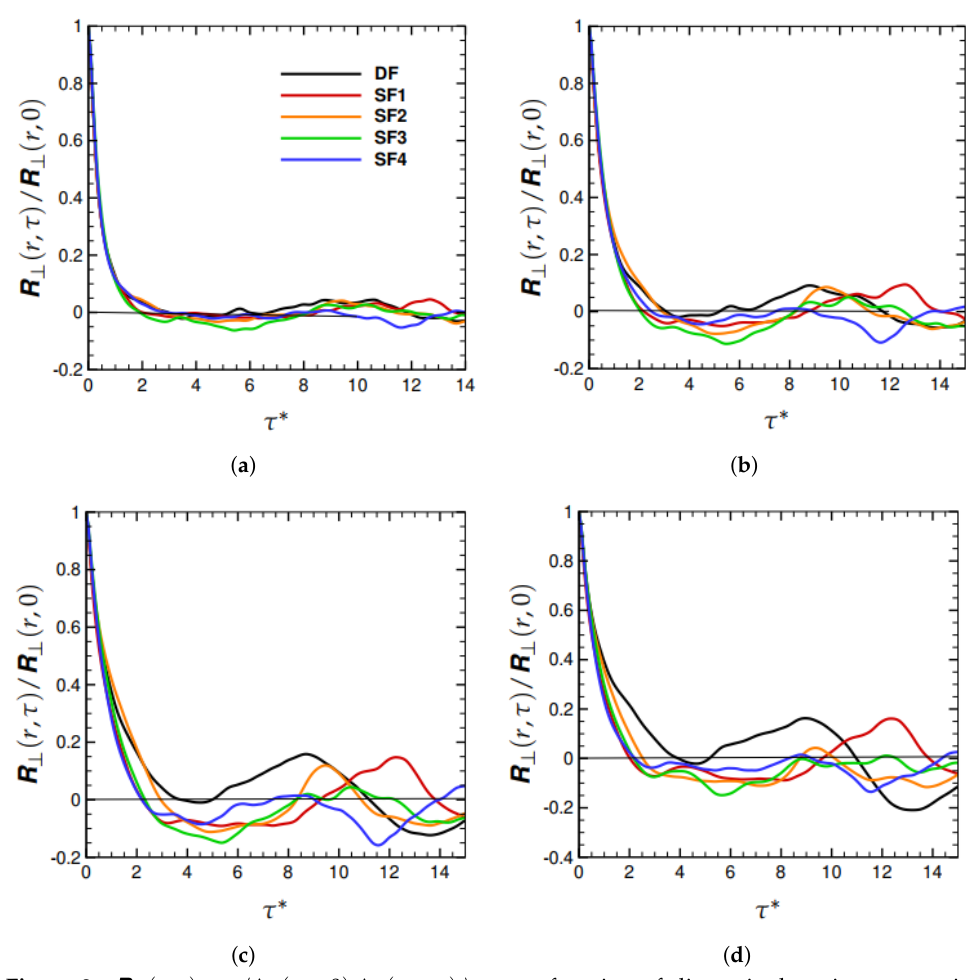
Figure 2. R ⊥ ( r , τ ) = (cid:104) ∆ u ( r , x ,0 ) ∆ u ( r , x , τ ) (cid:105) ⊥ as a function of dimensionless time separation,